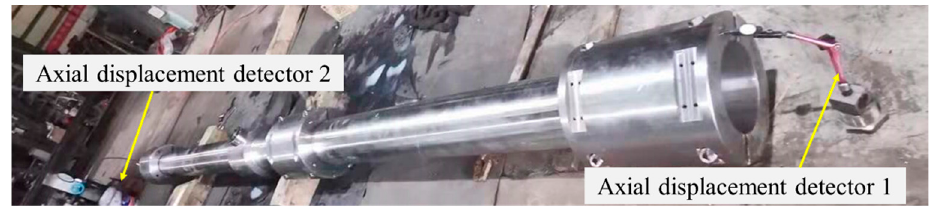
Figure 12. Drill pipe cabin test system. Table 6. Data for axial deformation of the drill pipe cabin.